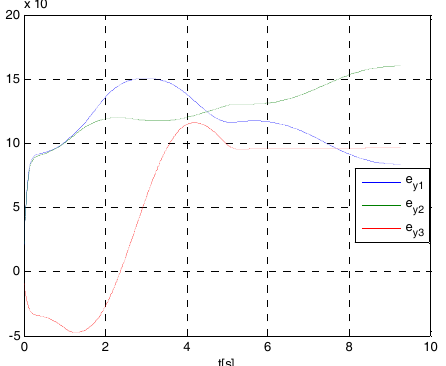
Figure 28. Time histories of the errors using the controller (73).